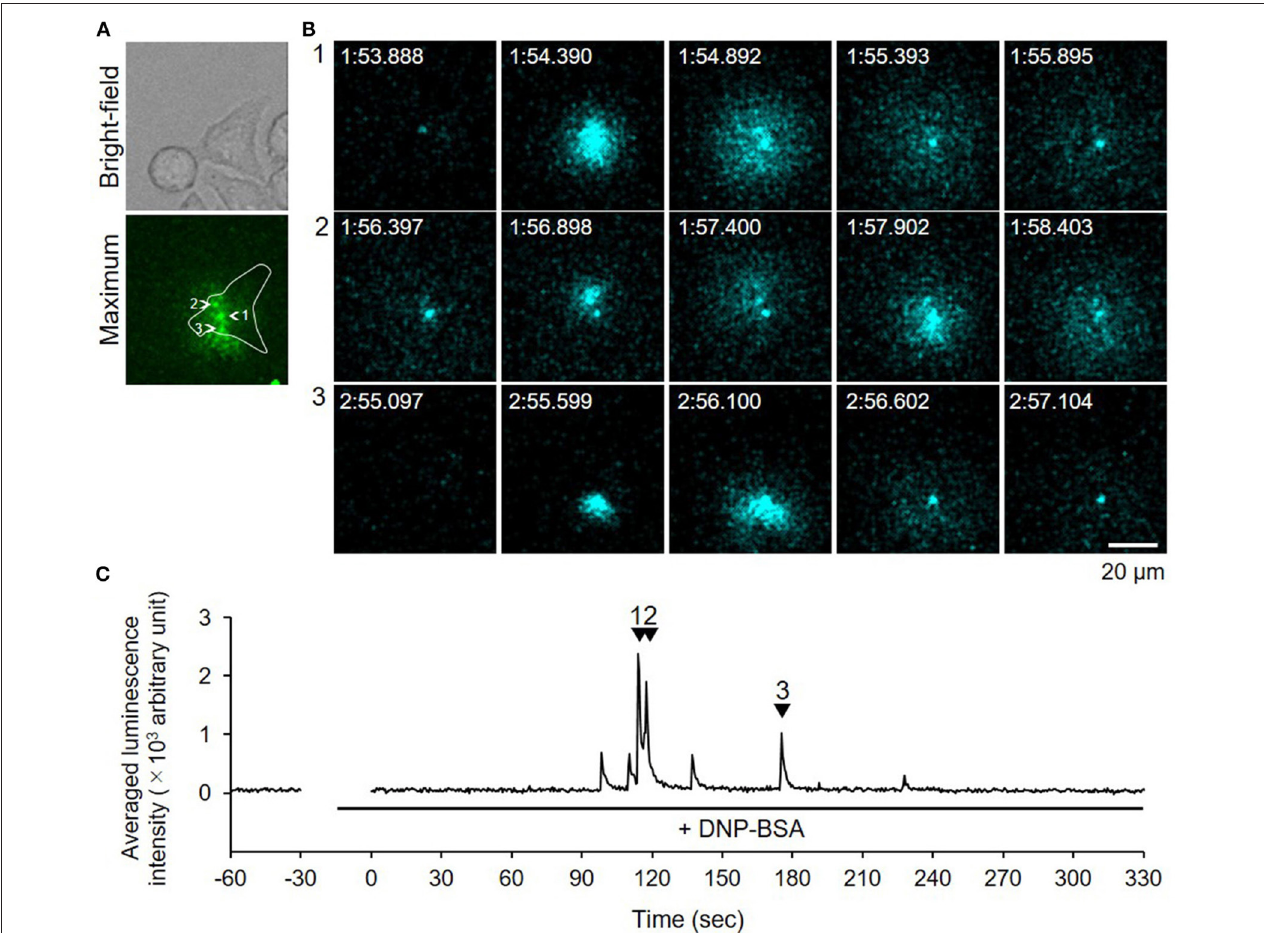
FIGURE 4 | Video-rate bioluminescence microscopy of NPY-GLase secretion from RBL-NPY-GLase cells attached to glass. (A) A bright field and luminescence images of RBL-NPY-GLase cells. The focal plane was adjusted to 2 µ m from the bottom side of the cells on the glass plate. A “maximum” image shows the maximum luminescence intensity obtained from all frames in the video image after stimulation with DNP-BSA. (B) Successive luminescence images of secreted NPY-GLase for a few seconds. Each sequential image (1–3) corresponds to the respective numbers with arrowheads in C . (C) Time-dependent changes in luminescence intensities of secreted NPY-GLase in the indicated area corresponding to the single cell in the “maximum” image.